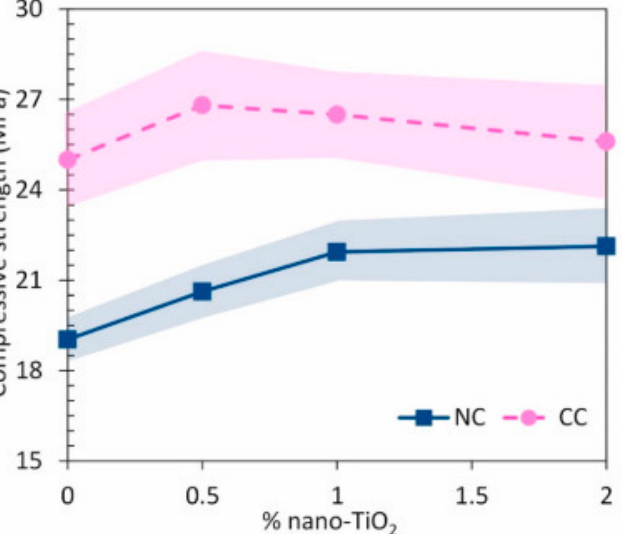
Figure 5. Change in compressive strength of normally and CO 2 -hardened cement pastes depending on the used dose of nano-TiO 2 [160] (RightsLink for Elsevier).